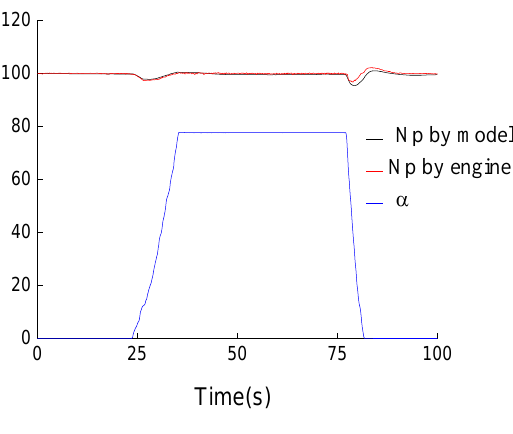
by the model and turbo-shaft engine. p